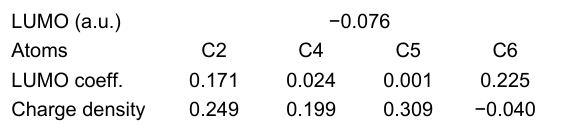
Table 2: LUMO coefficients and charge densities for the selected atoms in 1 obtained by DFT-B3LYP calculations. LUMO